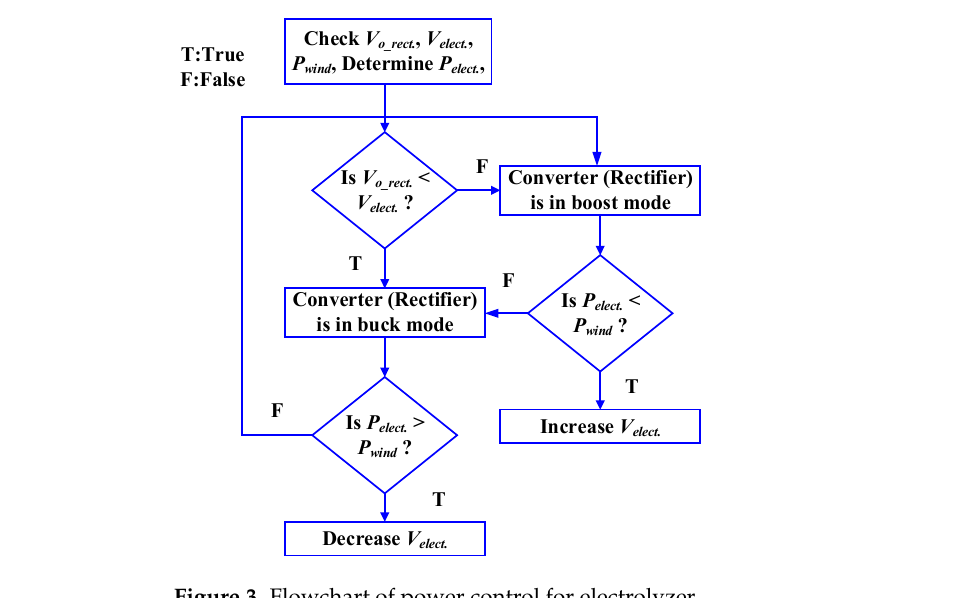
Figure 5. Efficiency versus rotor speed. Figure 6. Duty ratio versus rotor speed.